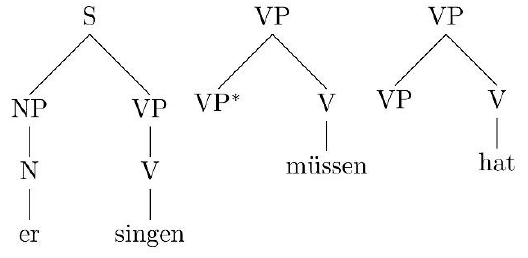
Figure 13. Elementary trees for the examples in (8)